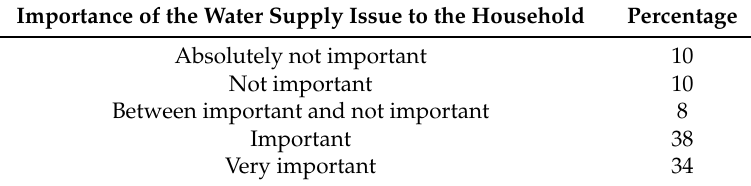
Table 4. Importance of the water supply issue to the household.